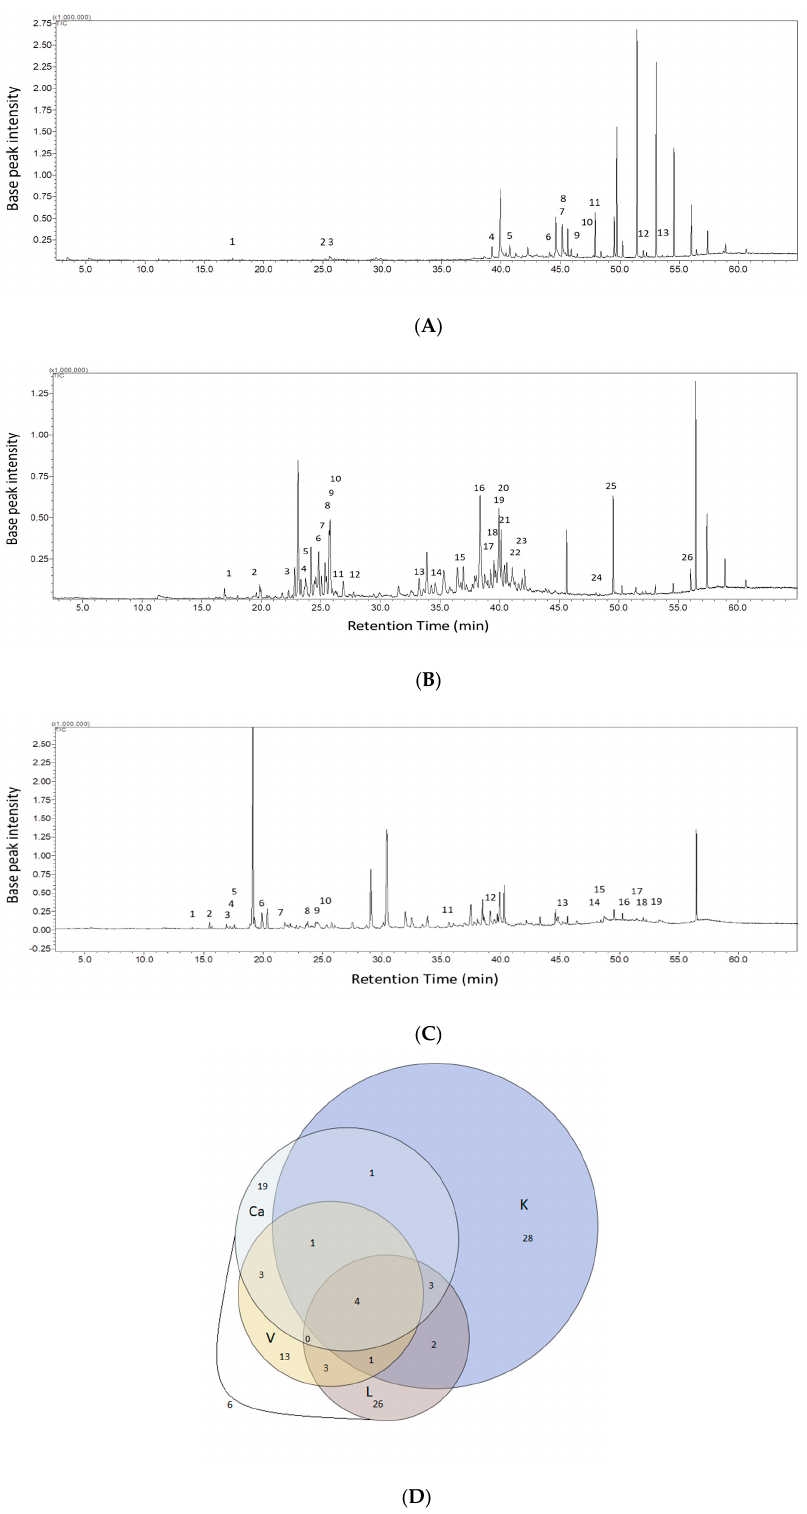
Figure 5. GC-MS chemical fingerprint of incense smoke from agarwoods. ( A ) Vietnam agarwood. ( B ) Liao agarwood. ( C ) Cambodian agarwood. Number indicates the compound specifically present in the agarwood. ( D ) Venn diagram of 110 compounds identified in the incense smoke from Kynam (K), Vietnam (V), Liao (L), and Cambodian (Ca) agarwoods. Table 2. Compounds commonly or specifically present in the incense smoke of agarwoods.